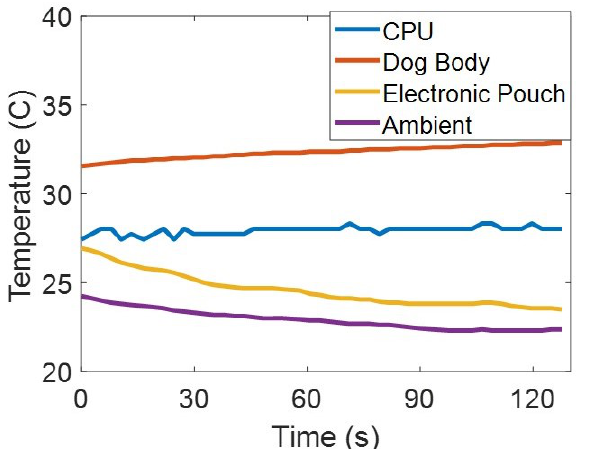
Figure 7. Measured temperatures from the electronics pouch, CPU, space between the dog body and the computer, and the ambient